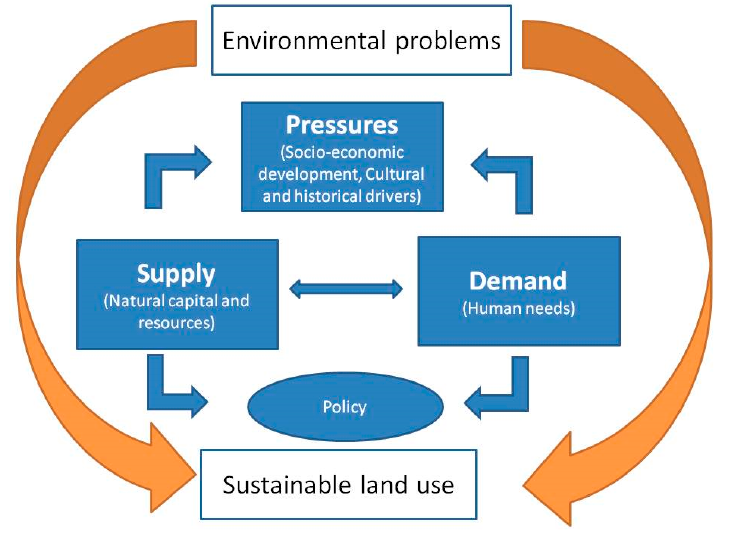
Figure 1. Integrated approach to sustainable land use management.